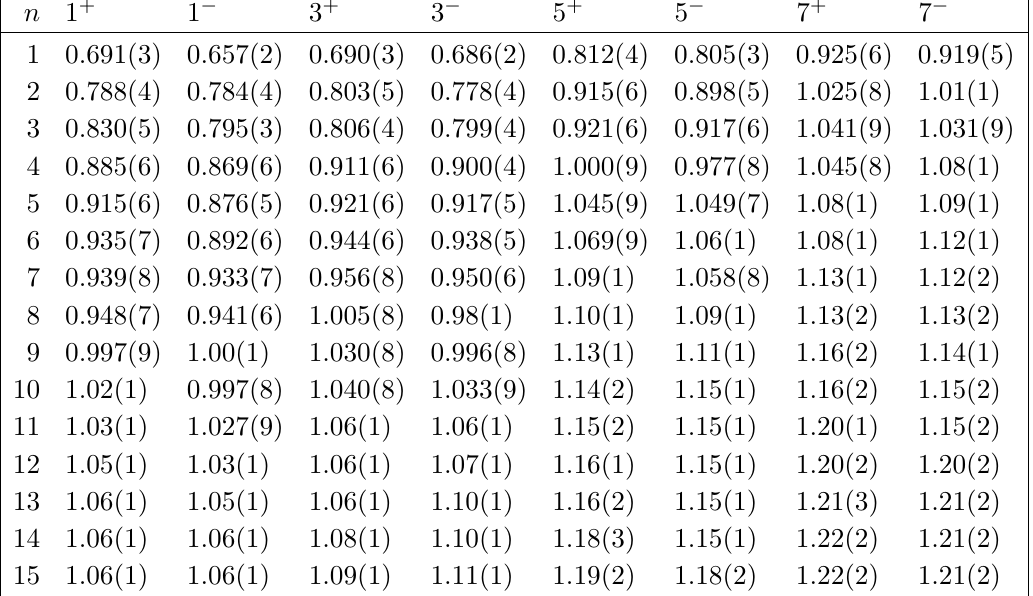
Table 9. Masses of glueballs within E representation of Z 4 averaged over P